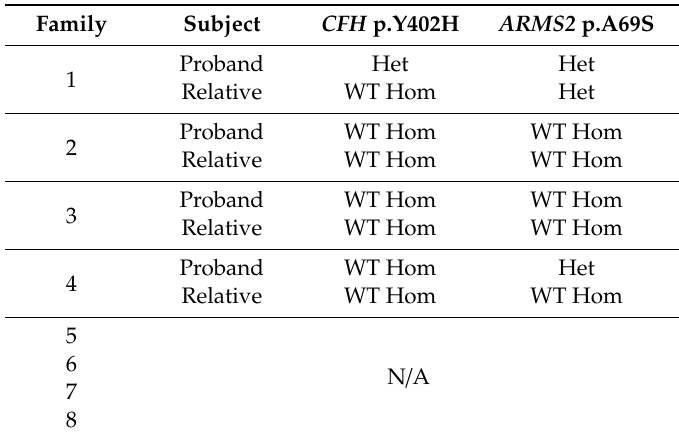
Table 2. Carrier status of common variants CFH p.Y402H and ARMS2